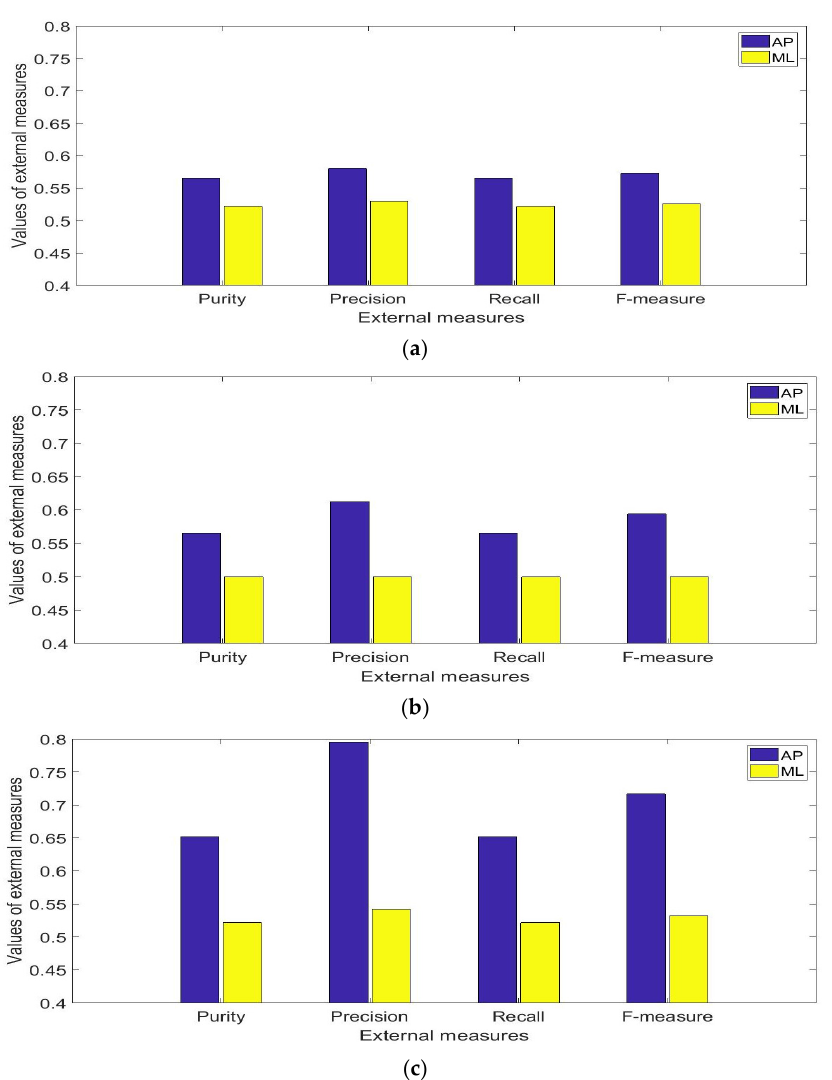
Figure 8. Results of median values of the external measures over 30 repetitions: ( a ) mCTSIB condi- tions 1 and 2, ( b ) mCTSIB conditions 1 and 3 ( c ) mCTSIB conditions 1 and 4. Table 1. Results of the median (interquartile range) values of the external measures for 30 clustering repetitions. mCTSIB Conditions